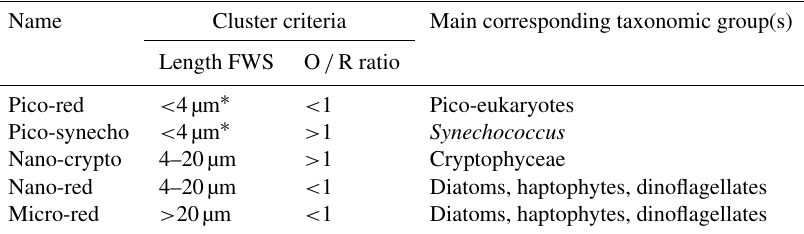
Table 2. The phytoplankton groups distinguished in the current study. Name Cluster criteria Main corresponding taxonomic group(s) Length FWS O / R ratio Pico-red < 4µm ∗ < 1 Pico-eukaryotes Pico-synecho < 4µm ∗ > 1 Synechococcus Nano-crypto 4–20µm > 1 Cryptophyceae Nano-red 4–20µm < 1 Diatoms, haptophytes, dinoflagellates Micro-red > 20µm < 1 Diatoms, haptophytes,